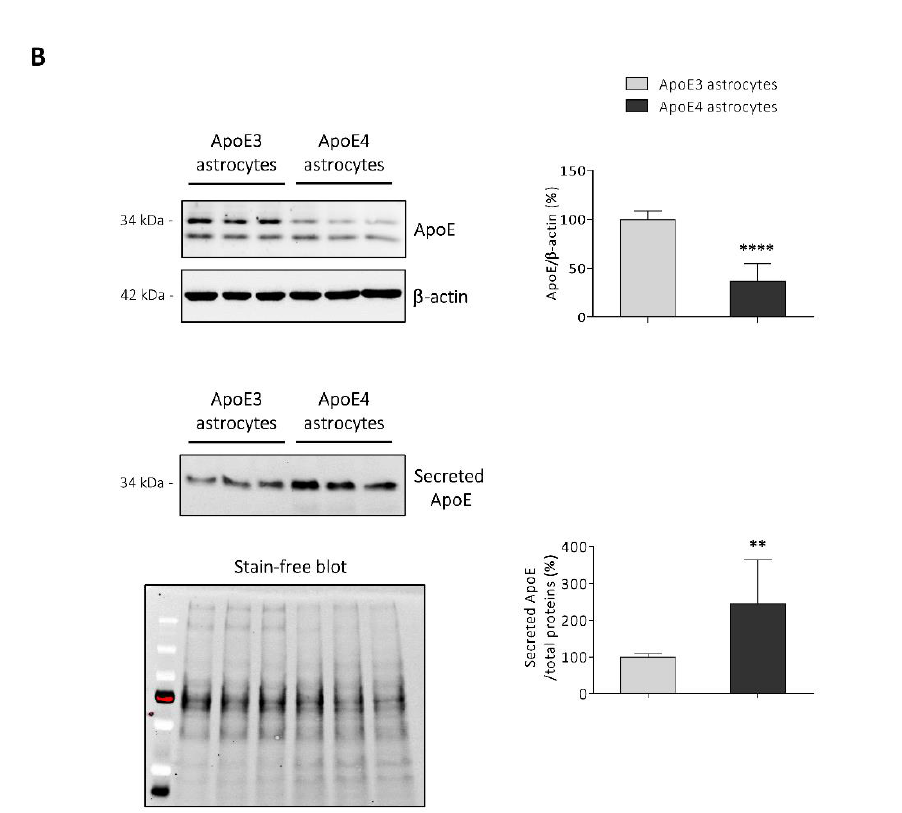
Figure 1. ApoE synthesis and release is altered in ApoE4 astrocytes. ( A ) ApoE protein levels were examined by immunocytochemistry. Antibodies detecting ApoE (red), and β -actin (green), were used and nuclei were stained with DAPI (blue). Representative images are shown. Cells were imaged by using an LSM800 confocal microscope (Zeiss, 63X oil objective; scale bar: 50 µ m). ( B ) ApoE protein levels were analysed by Western blotting in both cell lysates and concentrated media from ApoE3 and ApoE4 immortalized mouse astrocytes. Concerning cell lysates, ApoE levels were normalized to the corresponding β -actin levels and data are represented as percentages of average ApoE3 values. Data are expressed as mean values ± SD of four different experiments ( n = 14, Student’s t -test). Concerning concentrated media, ApoE levels were normalized to total proteins loaded into the corresponding well (Stain-free method) and data are represented as percentage of average ApoE3 values. Data are expressed as mean values ± SD of four different experiments ( n = 11, Student’s t -test). **** p < 0.0001, ** p < 0.01 vs. ApoE3